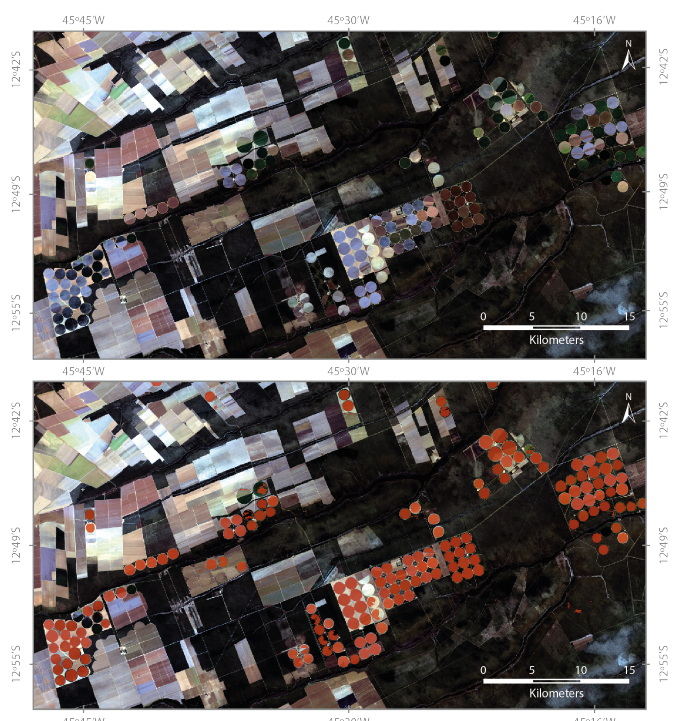
Figure 8. Results of the application of our model, trained in PlanetScope images, to a Landsat 8 OLI image localized in the state of Bahia, Brazil. The input image is shown at the top, and the results of the automatic mapping, in red, are at the bottom.